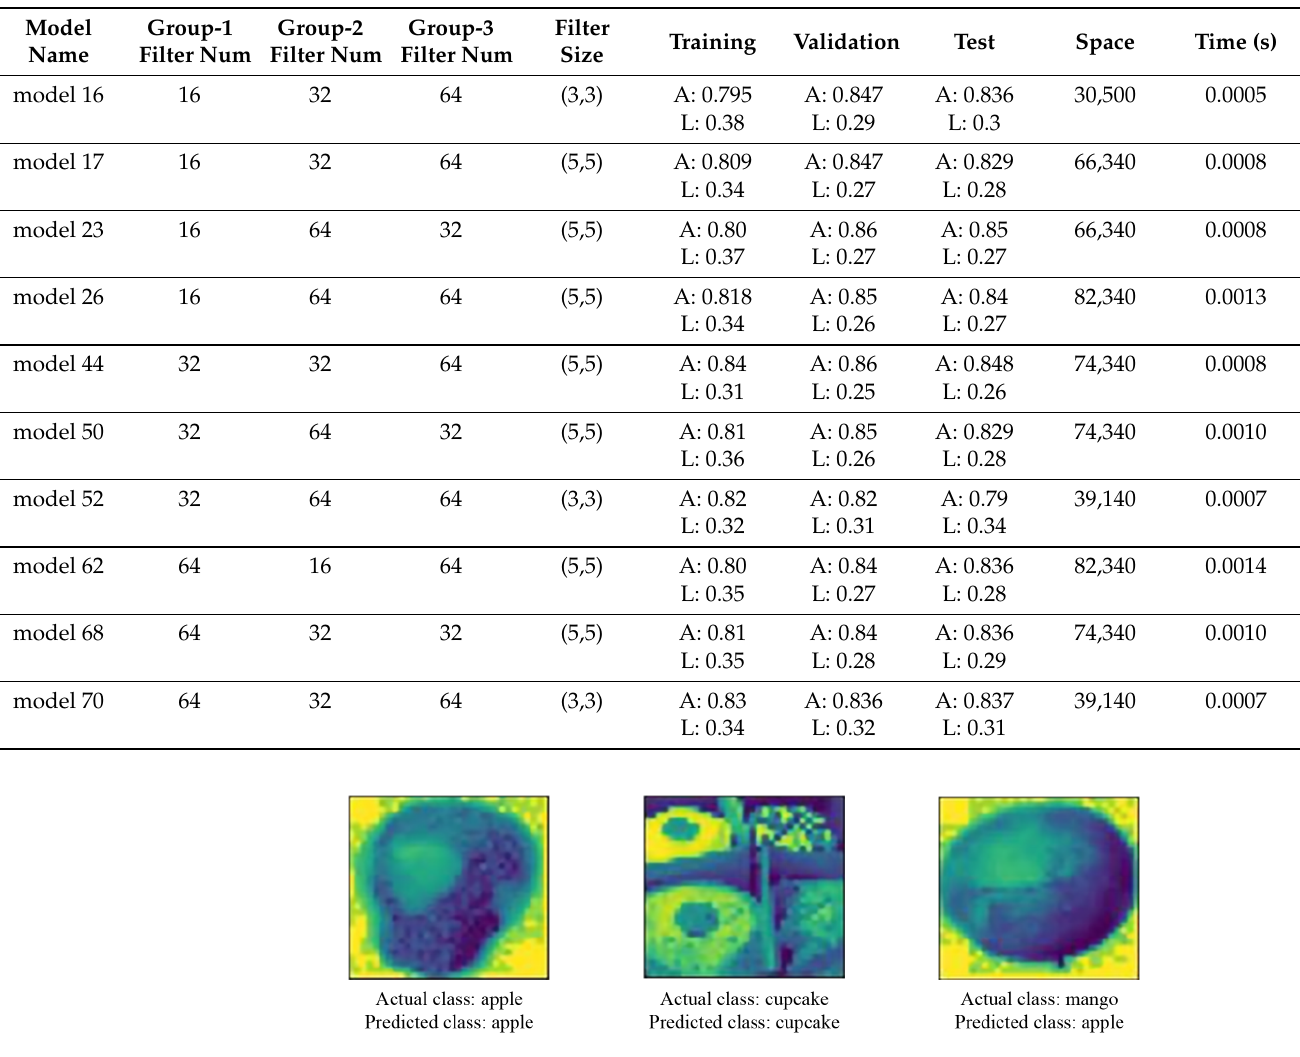
Table 5. Top 10 models performance comparison for the Accuracy (A), Loss (L), Space (in bytes), and Time (in seconds).